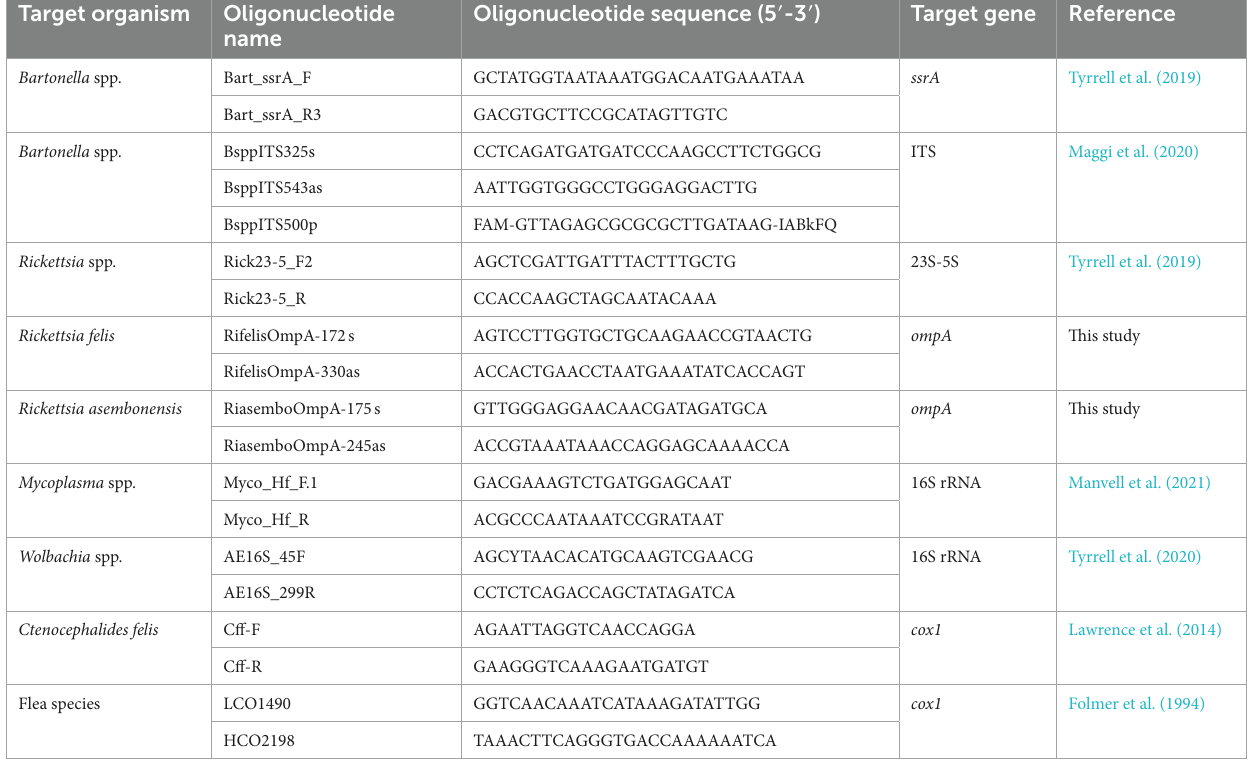
TABLE 1 Primers targeting housekeeping genes and pathogens including primer name, sequence, gene target, and reference to conditions. Target organism Oligonucleotide Oligonucleotide sequence (5 ′ -3 ′ ) name